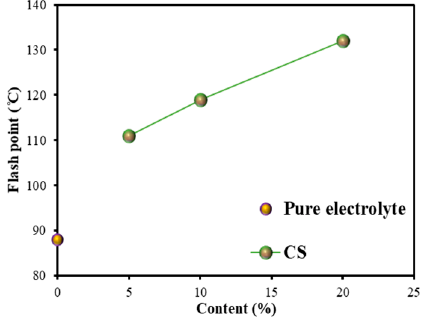
Figure 7. Flash point in function of content of FR.